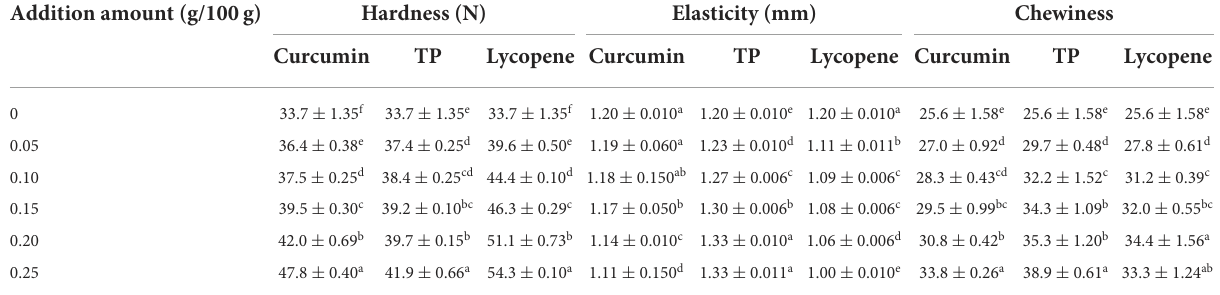
TABLE 1 Effect of addition amount of NAs on texture of NASNs.